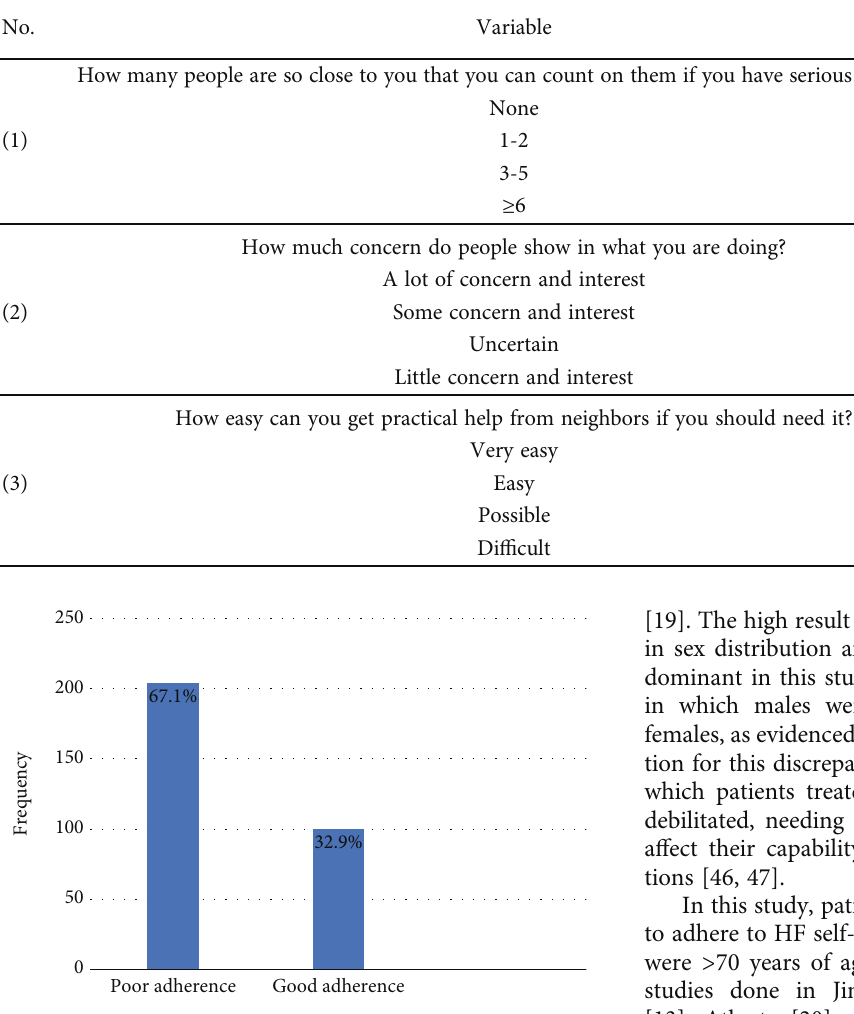
Figure 2: Adherence to self-care recommendations among HF patients, in West Gojjam Zone public hospitals, Northwest, Ethiopia,